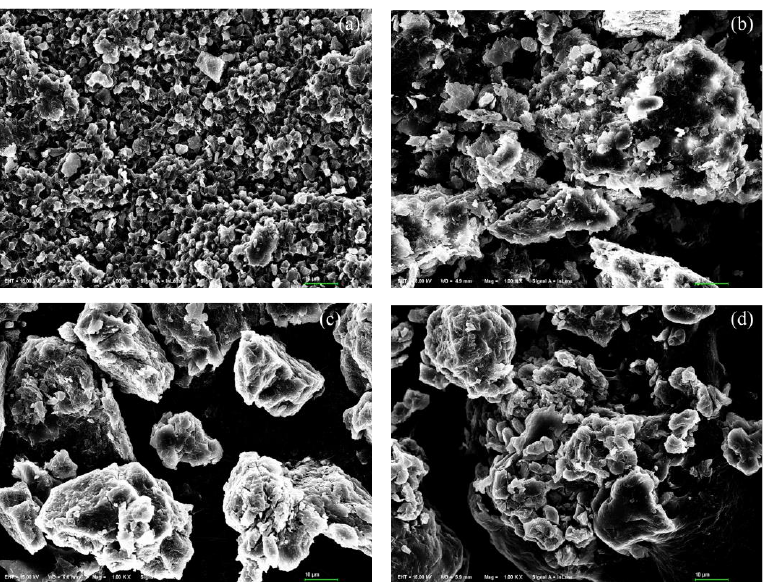
Figure 5. SEM image of ( a ) unmodified and ( b ) ZnCl 2 modified C. vulgaris , and ( c ) unmodified and ( d ) ZnCl 2 modified S. platensis.